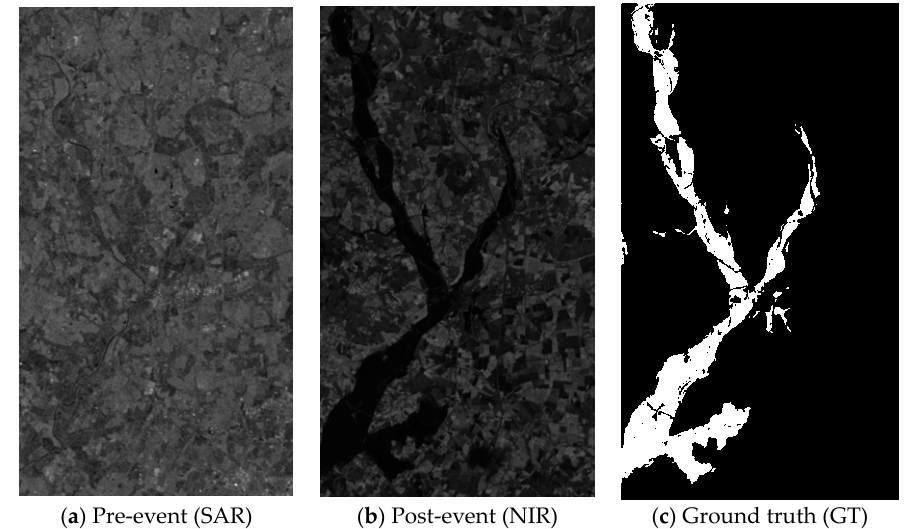
Figure 2. Image pair-1: IEEE Flood image pair (SAR–SPOT (NIR)). SAR: Synthetic aperture radar; NIR: Near infrared.